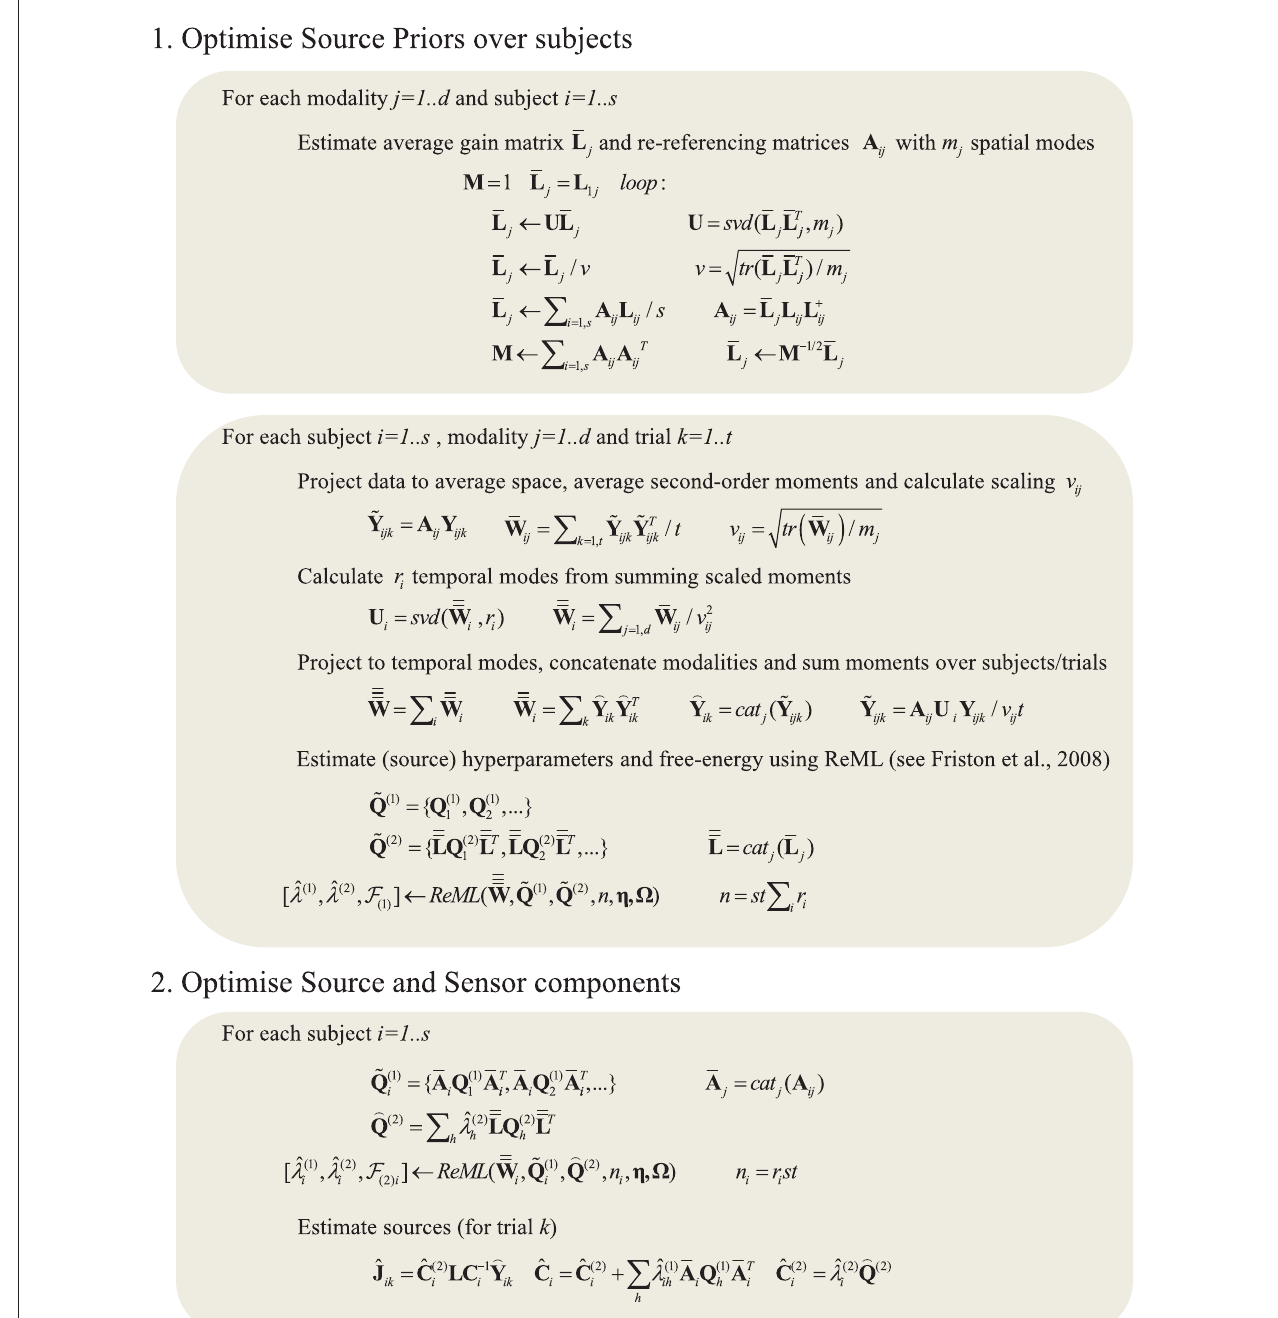
assumes a single set of k trials: the full code allows for different numbers of trials for different numbers of conditions. We have also ignored any filtering or temporal whitening of the data (see Friston et al., 2006, for more details). + refers to the pseudoinverse;